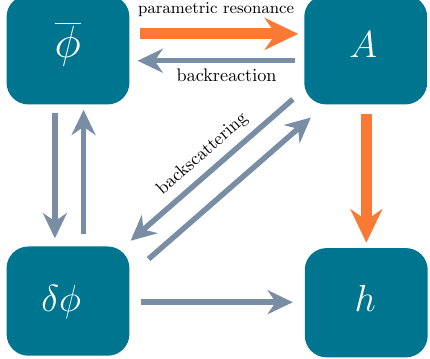
Figure 1 . Schematic diagram showing the interplay between different degrees of freedom in the model. Ignoring metric perturbations we have axion background ( ¯ φ ), dark photons ( A ) and axion fluctuations ( δφ ). Because of the axion oscillations, its own fluctuations and dark photons are produced due to parametric resonance. However, the dynamics is nonlinear as A and δφ affect each other’s dynamics (backscattering) as well as ¯ φ (backreaction). Besides, we must include metric perturbations. Here we have shown only the tensor modes ( h ) which can be produced from photons and axion particles. The analytic investigations of this work is focused on the orange